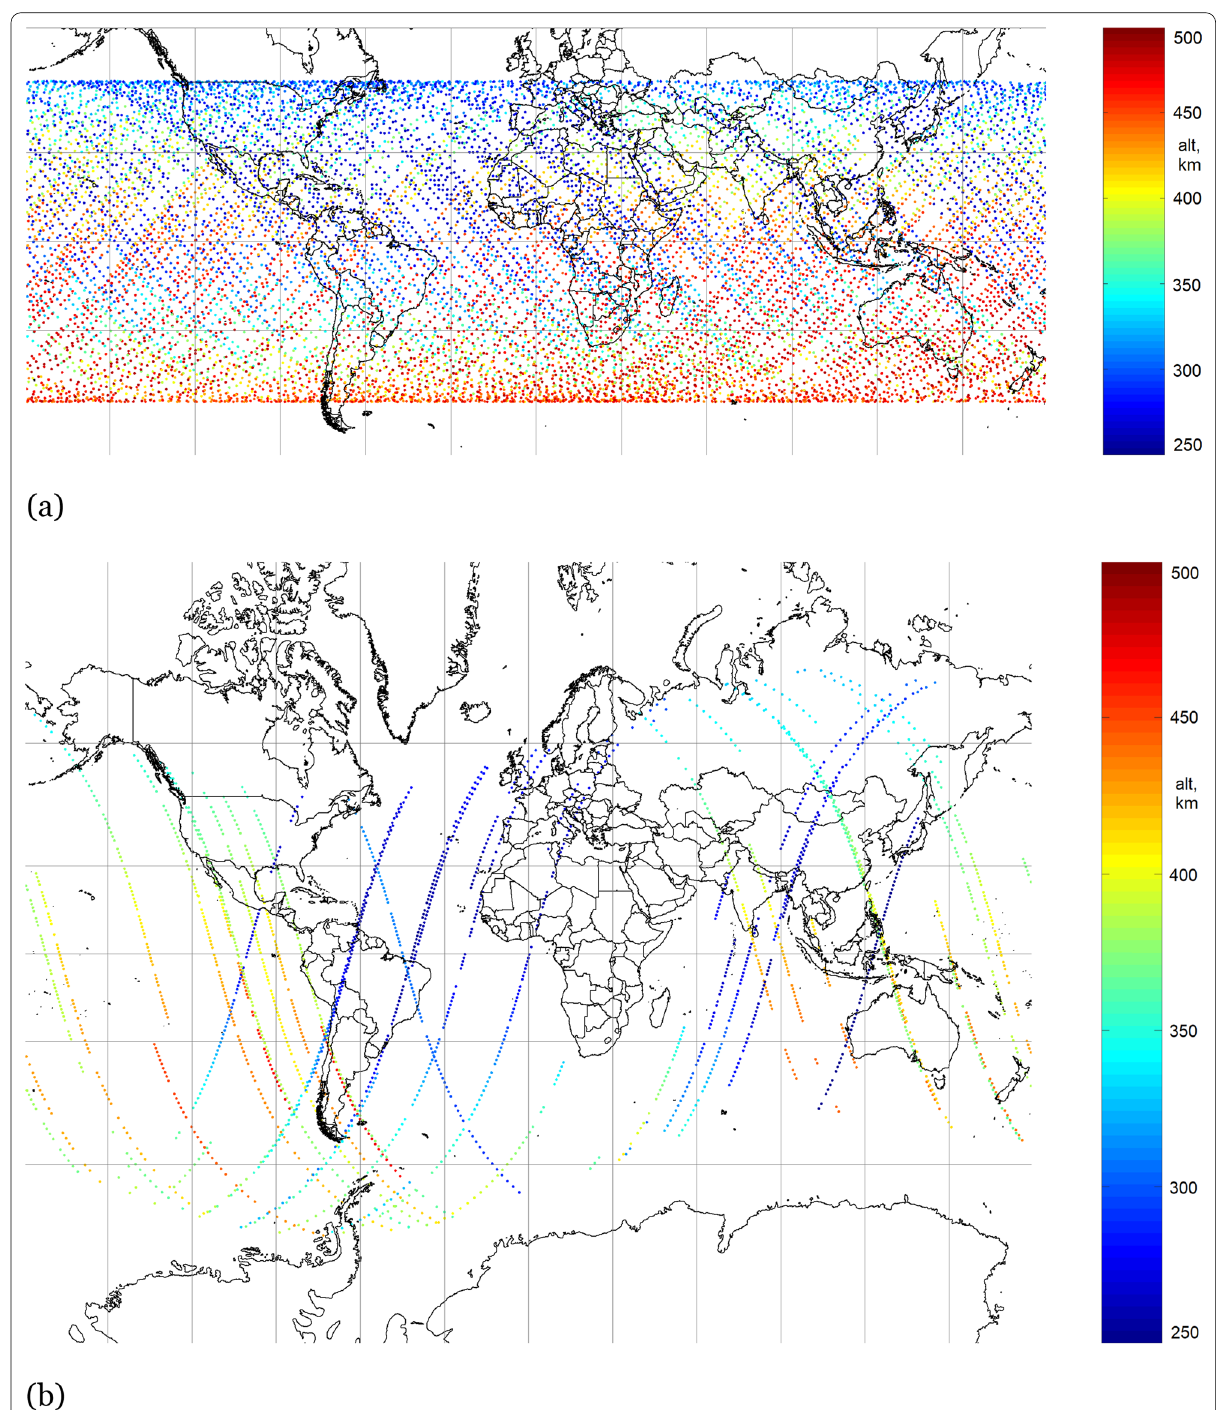
Fig. 7 Spatial distribution of the measurements by the Kosmos-49 ( a ) and Kosmos-321 ( b ) satellites selected for the N-1 and N-2 models, respectively. The color scale denotes the flight altitude in